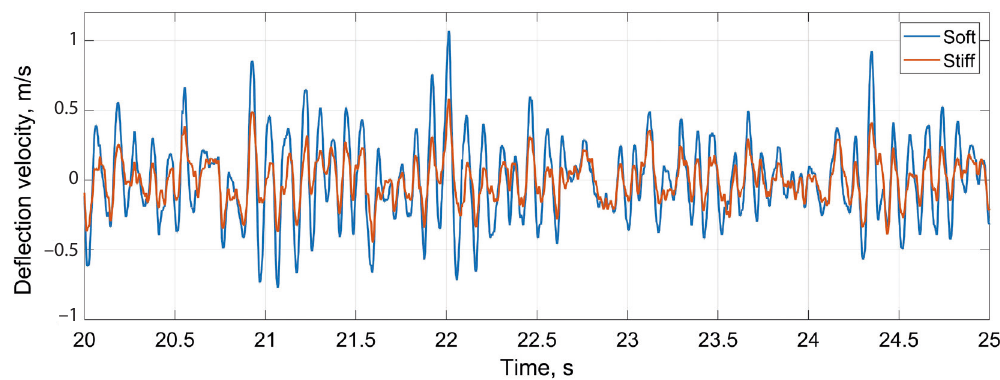
Figure 6. Suspension deflection velocity of the most loaded front right vehicle corner at different damping modes (D class, 90